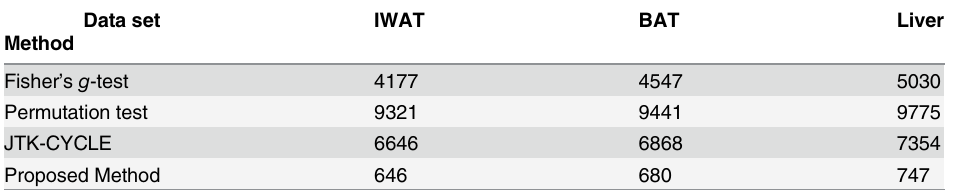
Table 4. IWAT, BAT and Liver data sets: number of circadian genes identified using Fisher ’ s g -test, Permutation test and JTK-CYCLE respectively. Data